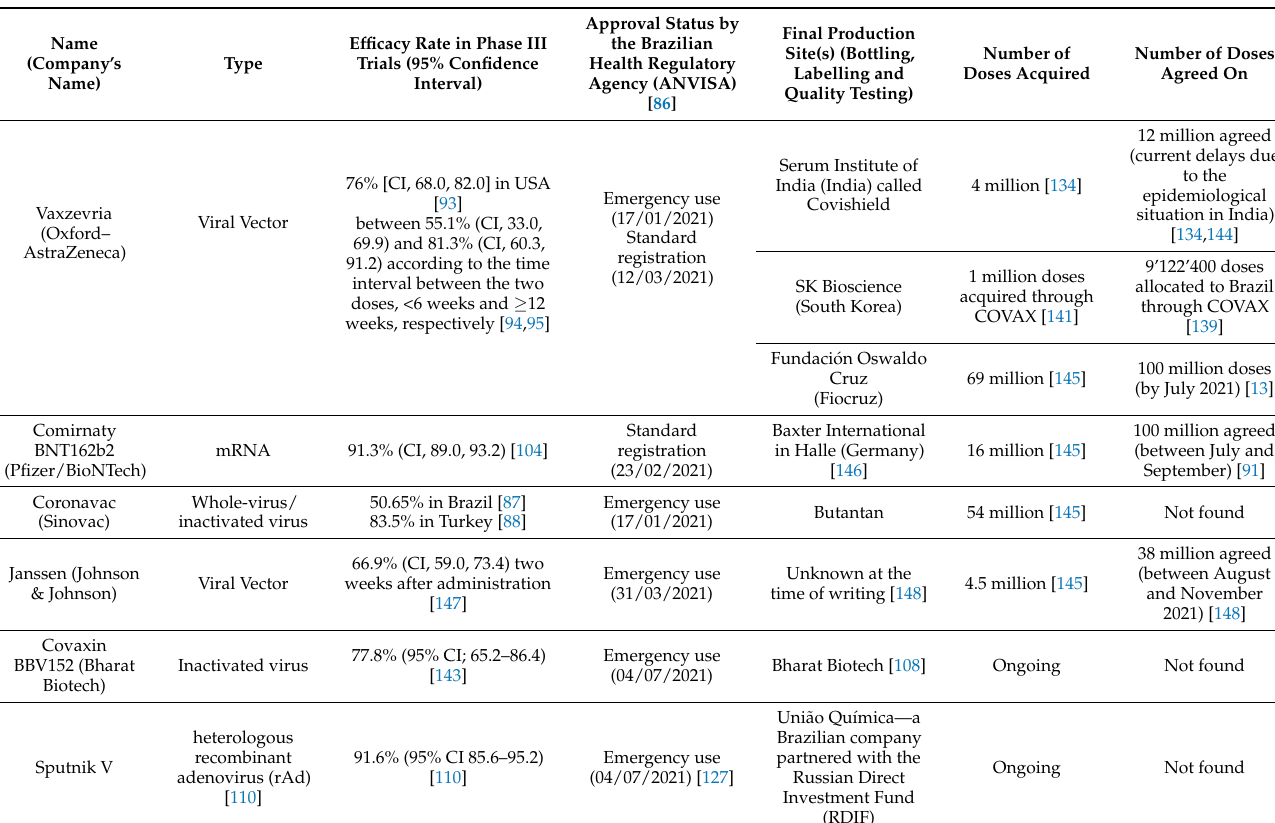
Table 1. List of vaccines available or planned to be available in Brazil as of the 18th of July